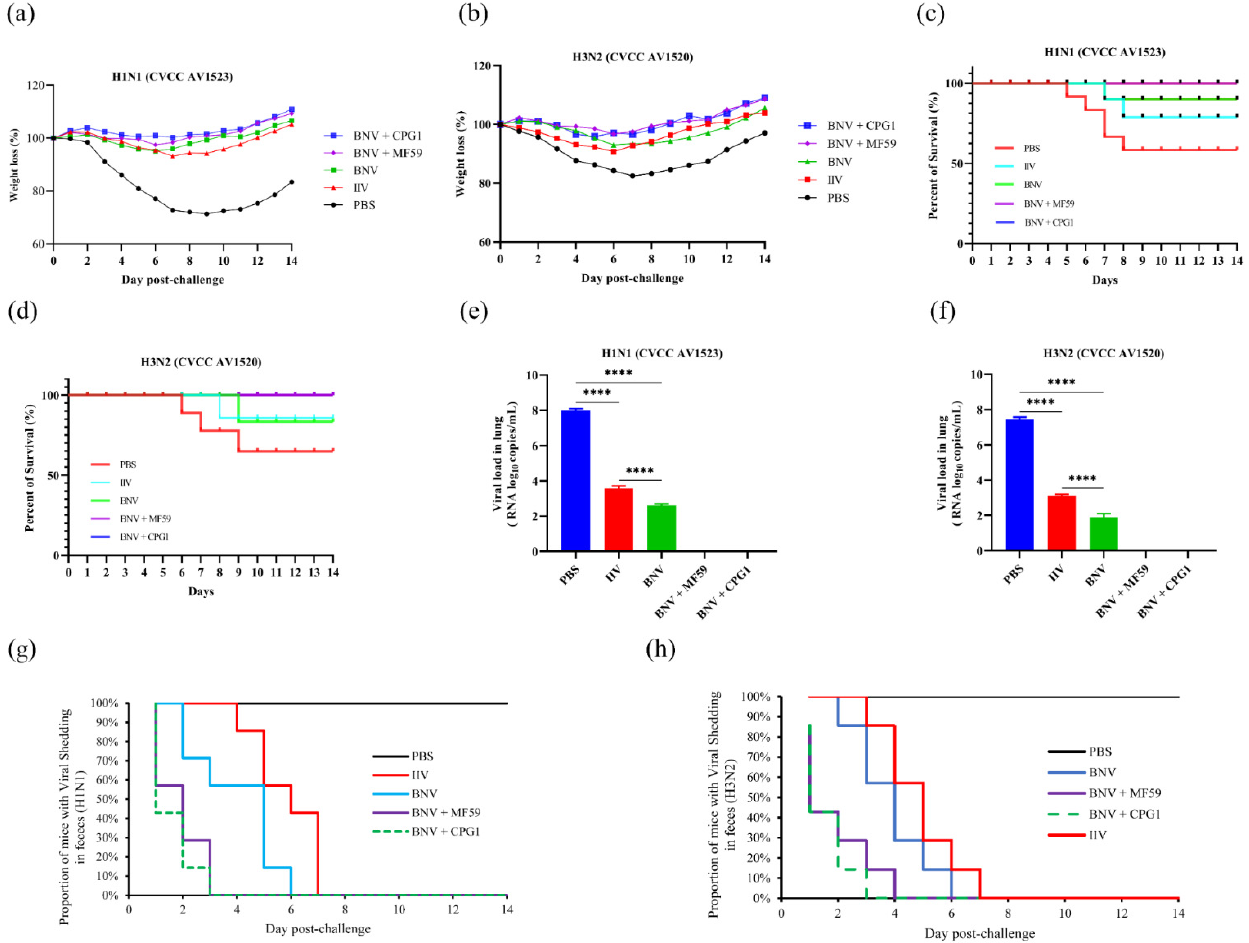
Figure 5. Mice were immunized with BNV-nanoparticle, MF59-adjuvanted, or CPG1-adjuvanted BNV and challenged with swine influenza H1N1 (CVCC AV1523) and H3N2 (CVCC AV1520) viruses. ( a , b ) Weight changes of mice challenged with swine influenza H1N1 and H3N2 in each group are shown. Values indicate the mean weight changes of all mice in each group after the virus challenge. ( c , d ) The survival rates were analyzed by Kaplan–Meier methods ( n = 8/group). ( e , f ) Viral loads in lung tissues of mice six days post-challenge with H1N1 and H3N2 viruses are shown (**** p < 0.0001). ( g , h ) Duration of viral shedding in feces samples post-challenge with H1N1 and H3N2